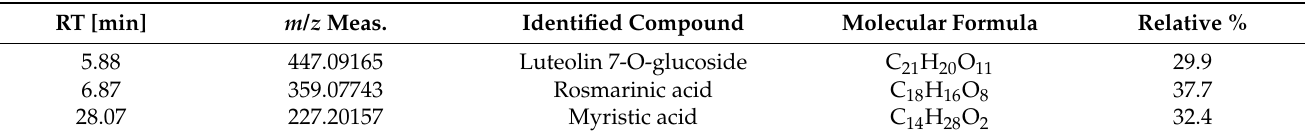
Table 3. LC-MS results of the identified compounds in the ethanol extract of L. angustifolia.